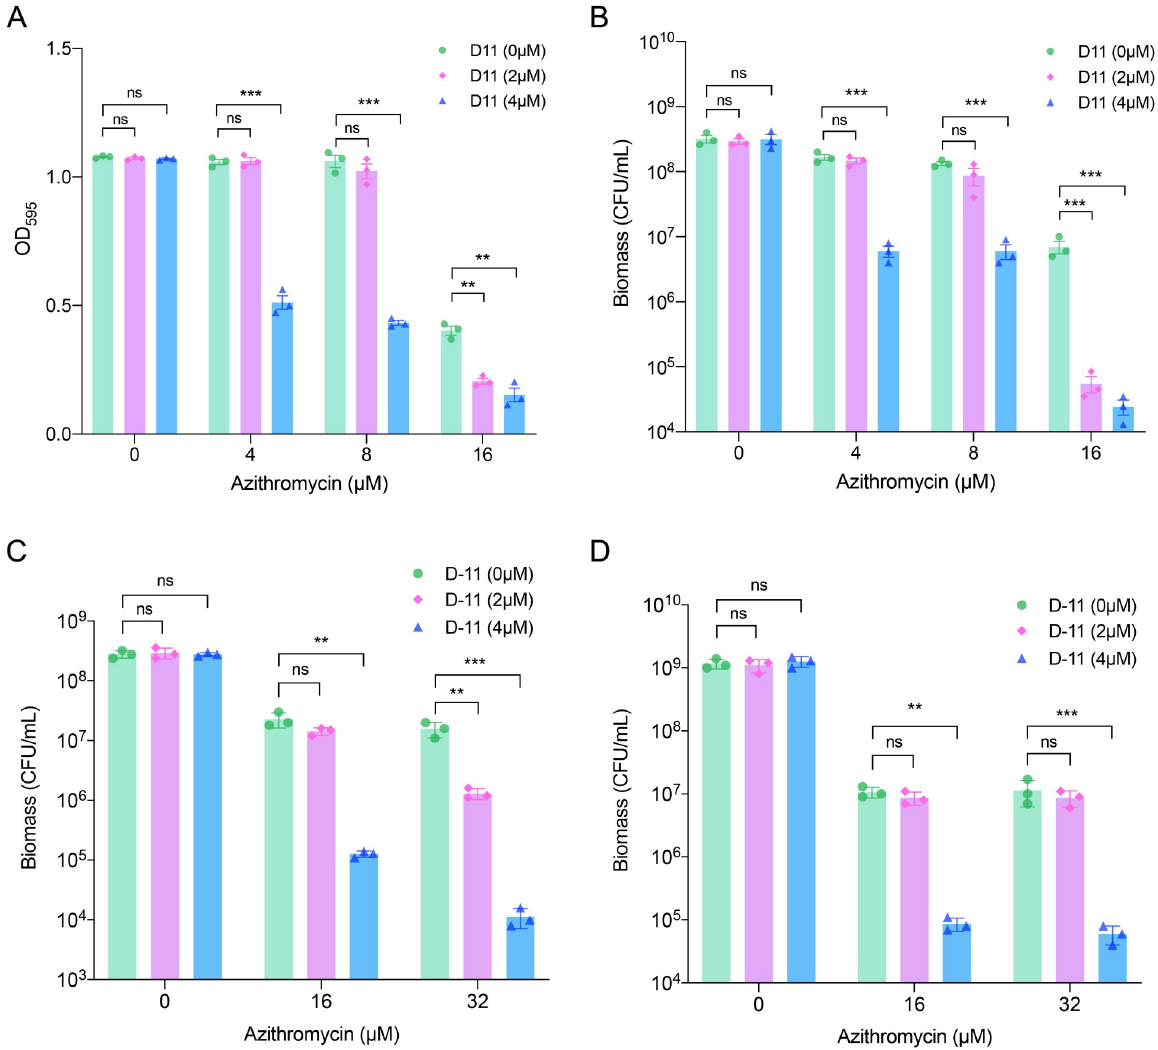
Fig 5. D-11 increase the anti-biofilm ability of azithromycin. ( A ) The biofilm was grown at the indicated conditions and stained with crystal violet. The crystal violet was dissolved in ethanol and measured at a wavelength of 595 nm. ( B ) The biofilm was grown at the indicated conditions and dispersed by ultrasound. The bacterial count inside of biofilm was determined by plating. The established biofilm was treated with indicated conditions for 24 hours. The bacterial count inside the biofilm ( C ) or in the supernatant ( D ) was determined by plating. All the tests were performed in triplicate and all the data are presented as mean ± SEM. �� , P < 0.01; ��� , P < 0.001; ns, not significant by Student’s